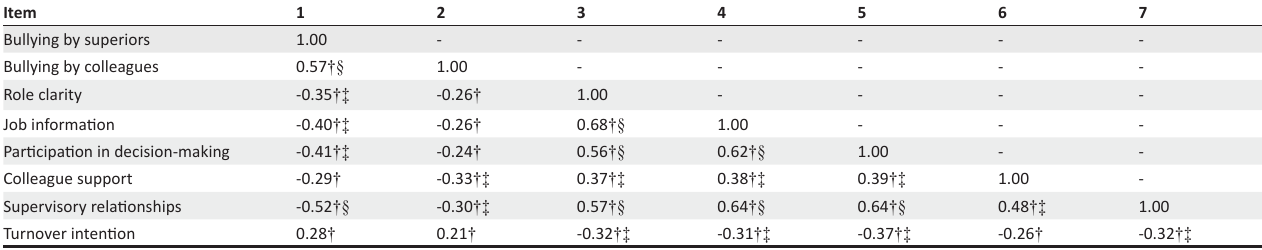
TABLE 3: Correlation coefficients between workplace bullying (superiors and colleagues), POS and turnover intention.